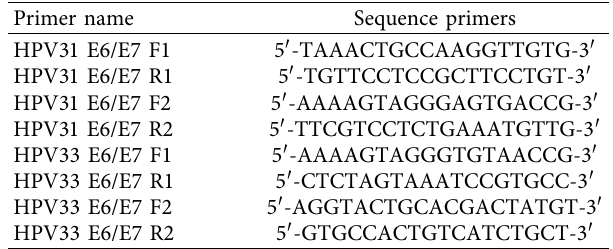
Table 1: Primers used for the molecular characterization of HPV31 and HPV33 E6 and